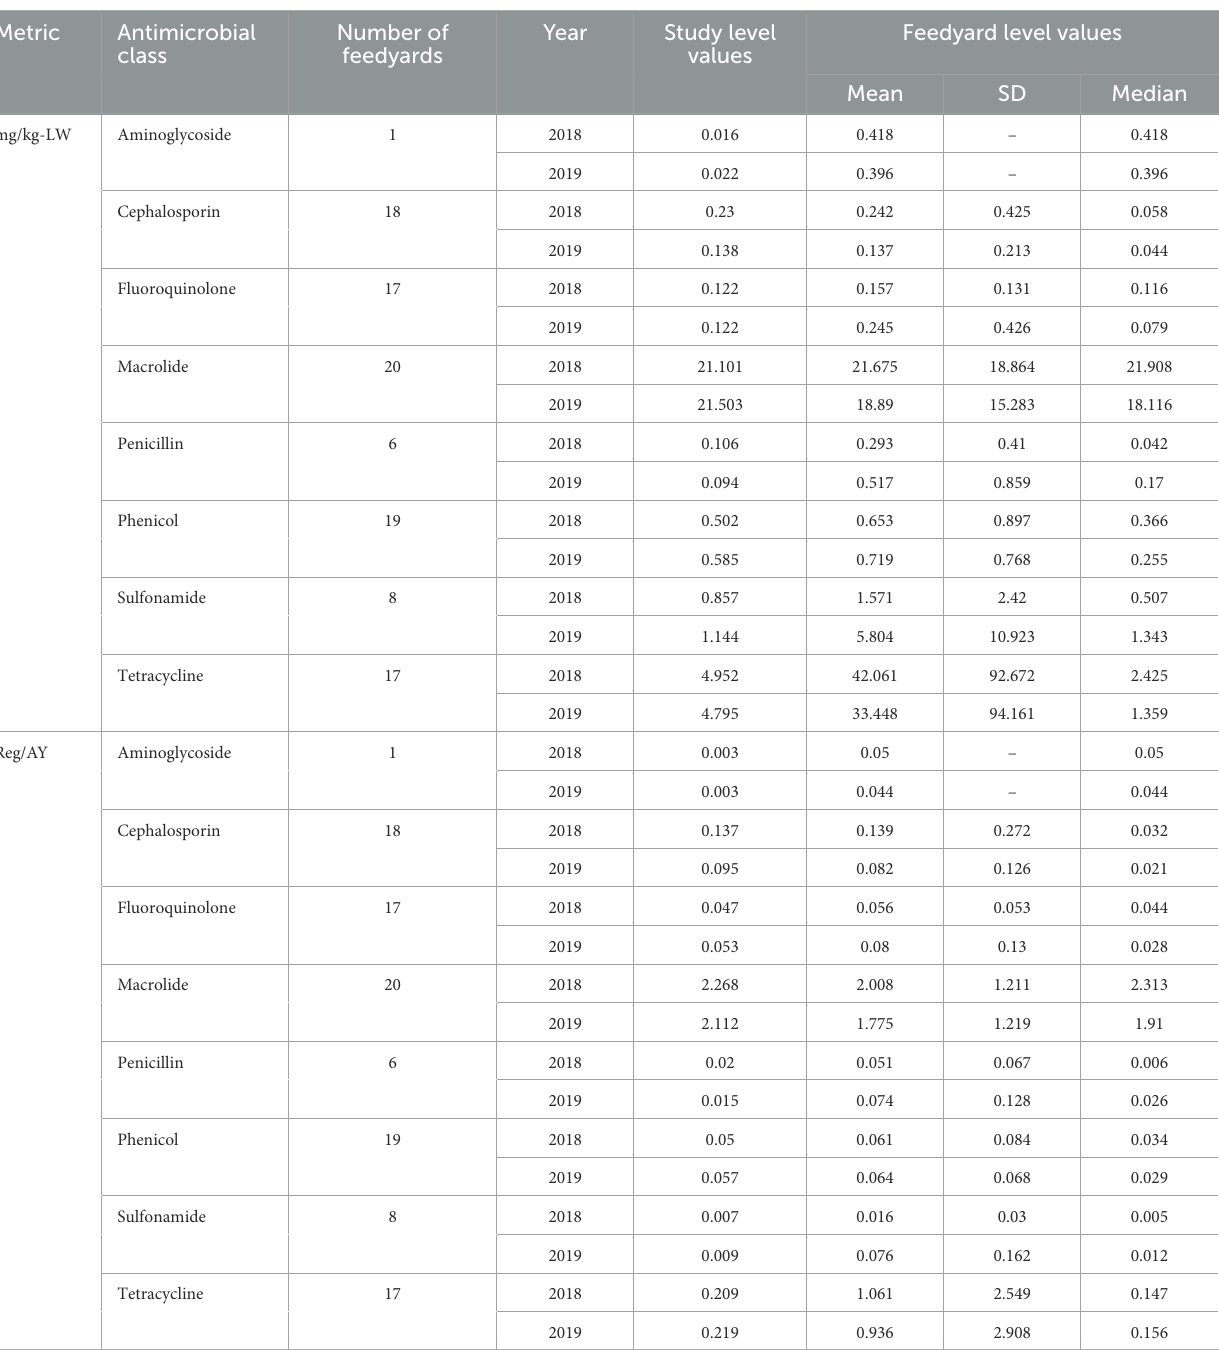
TABLE 7 Milligrams per kilogram-LW and Reg/AY calculated at the feedyard level by medically important antimicrobial class.